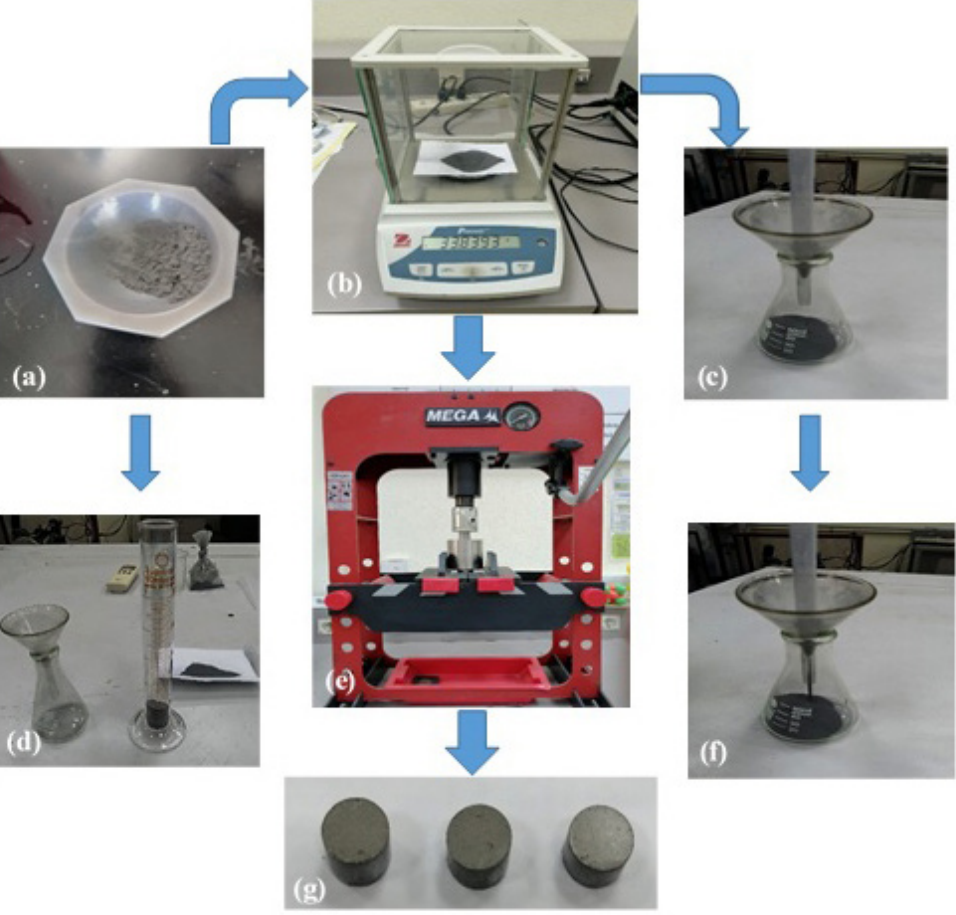
Figure 1. Experimental setup representation; (a) Agate, (b) Electronic balance 4-digits, (c) Beakers with iron powder, (d) Beakers for measuring the shaking density of IP, (e) Hydraulic press, (f) Measuring IP flow rate, (g) Produced specimens by powder